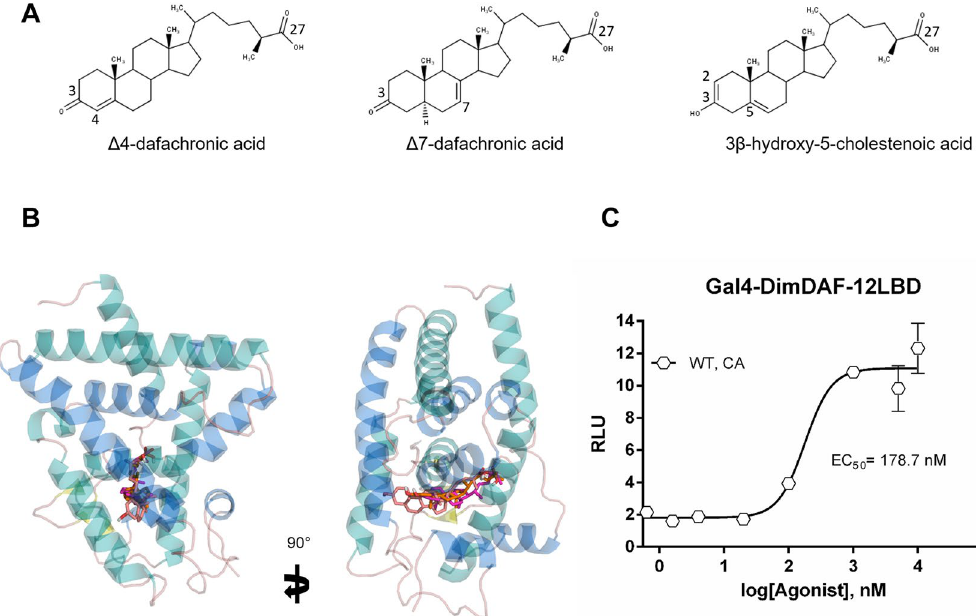
Figure 7. Cholestenoic acid binds and activates DimDAF-12. A Chemical structures of Δ4-dafachronic acid (Δ4-DA), Δ7-dafachronic acid (Δ7-DA) and 3β-hydroxy-5-cholestenoic acid (CA). B Predicted structures of the complexes of DimDAF-12 formed with Δ4-DA (green), Δ7-DA (pink) and with CA (magenta). In silico docking showed that the ligand binding pocket of DimDAF-12 accommodates CA. All images were generated using PyMol. C CA activates DimDAF-12 in a dose-dependent manner. NIH3T3 cells were co-transfected with Gal4-DimDAF-12_LBD and luciferase gene reporter construct. Recombinant cells were incubated with increasing concentrations of CA (up to 10 µM). The ligand binding and transactivation activity were assessed by measuring the luciferase activity, which was normalized by Renilla luciferase activity for transfection efficiency and expressed as relative light units (RLU). Data represent the average of normalized luciferase activity and the error bars correspond to the standard error of mean from a triplicate assay. The experiments were repeated at least two times in triplicate. The figure shows a representative experiment performed in triplicate using Prism 6.0 (Graph Pad Software,